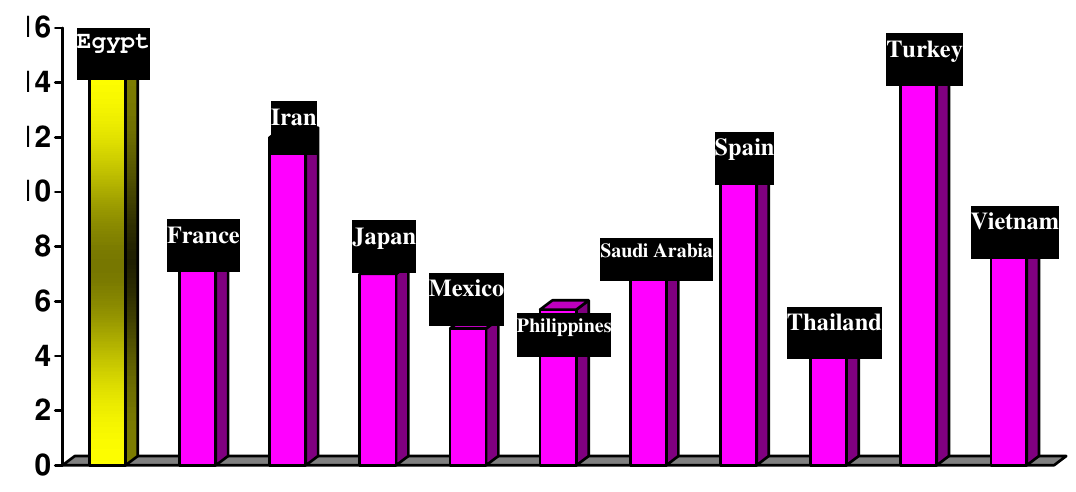
FIGURE 2 . Incidence of CAD in the Middle East area vs. Europe. Registry by the